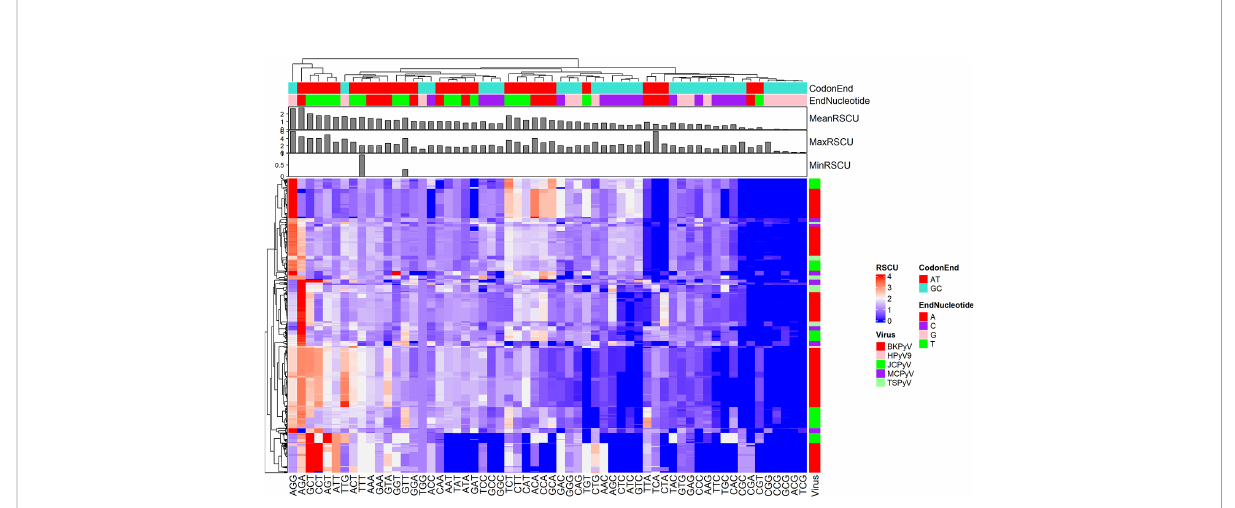
FIGURE 1 Heatmap showing the relative synonymous codons of human genes and genes of